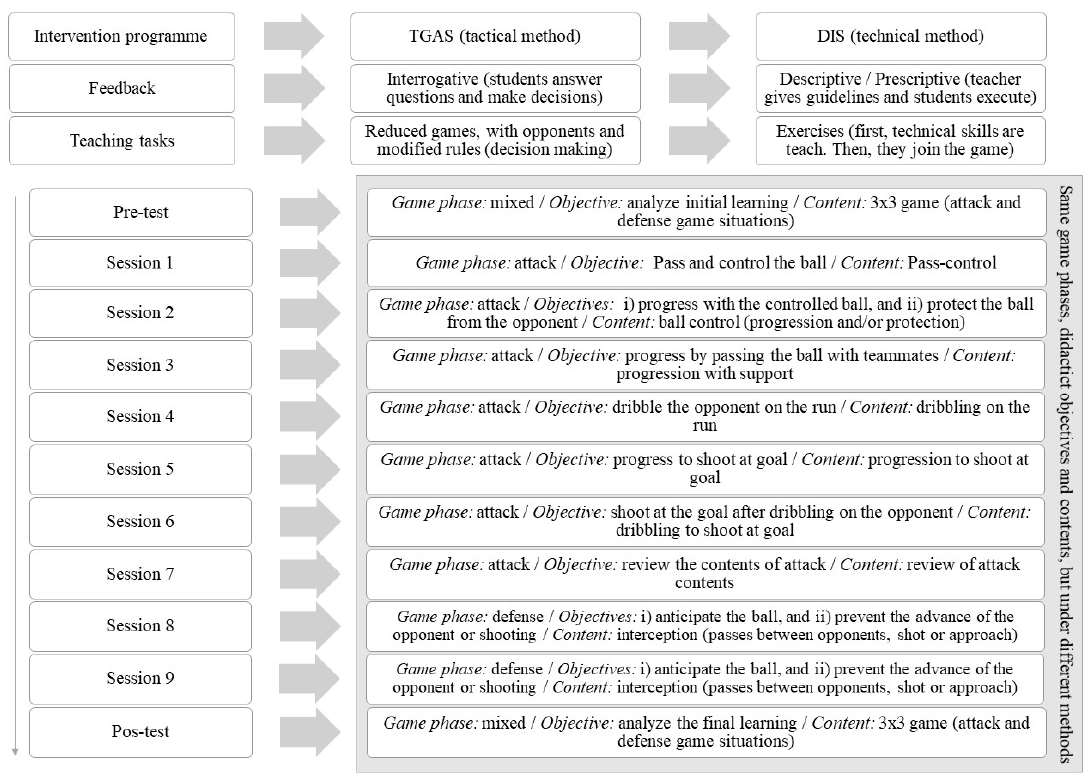
Figure 2. Distribution of the content for each methodological proposal.